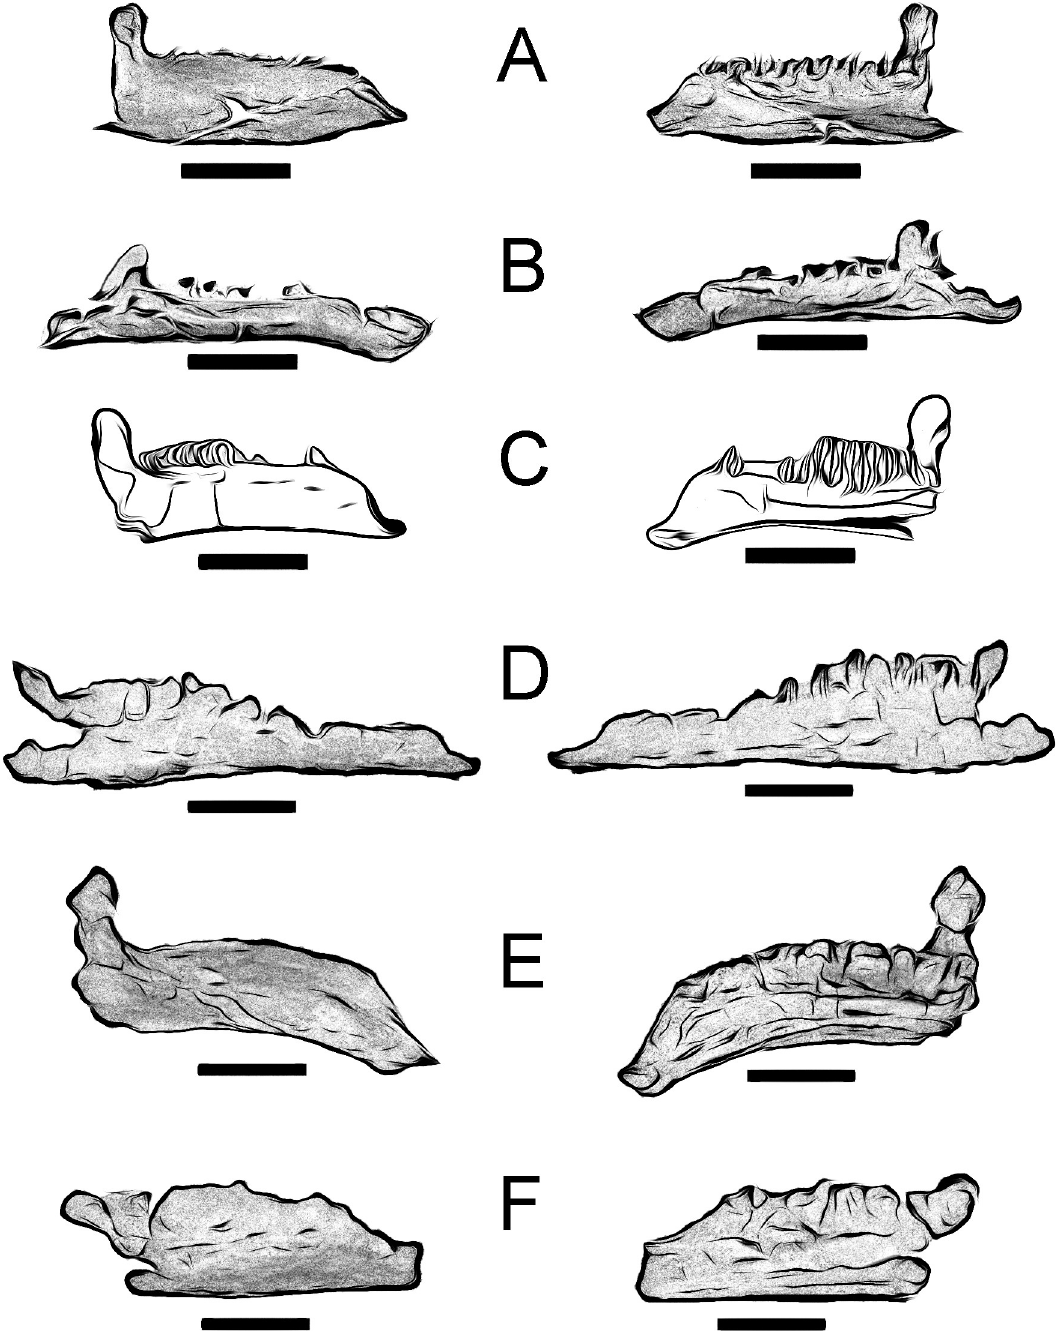
Fig 5. Inflected ventral margin of the rostral ramus of some styracosternans from the Lower Cretaceous in comparison with P . sosbaynati gen. et sp. nov. Medial and lateral views. Scale bar equals 10 cm. (A) Fukuisaurus tetoriensis (FPDM-V-40-9, vertically reversed, drawing from Fig 4 in Kobayashi and Azuma [35]). (B) Mantellisaurus atherfieldensi s (NHMUK PV R 11521, vertically reversed, drawing from Fig 3 in McDonald [54]). (C) Probactrosaurus gobiensis (PIN 2232/42-1, drawing from Fig 12 in Rozhdestvensky [42]). (D) Hypselospinus fittoni (NHMUK PV R 1831, drawing from Fig 36 in Norman [12]). (E) Proa valdearinnoensis (AR-1-1365, drawing from Fig 6 in McDonald et al. [11]). (F) Portellsaurus sosbaynati gen. et sp. nov. (MQ98-II-1).